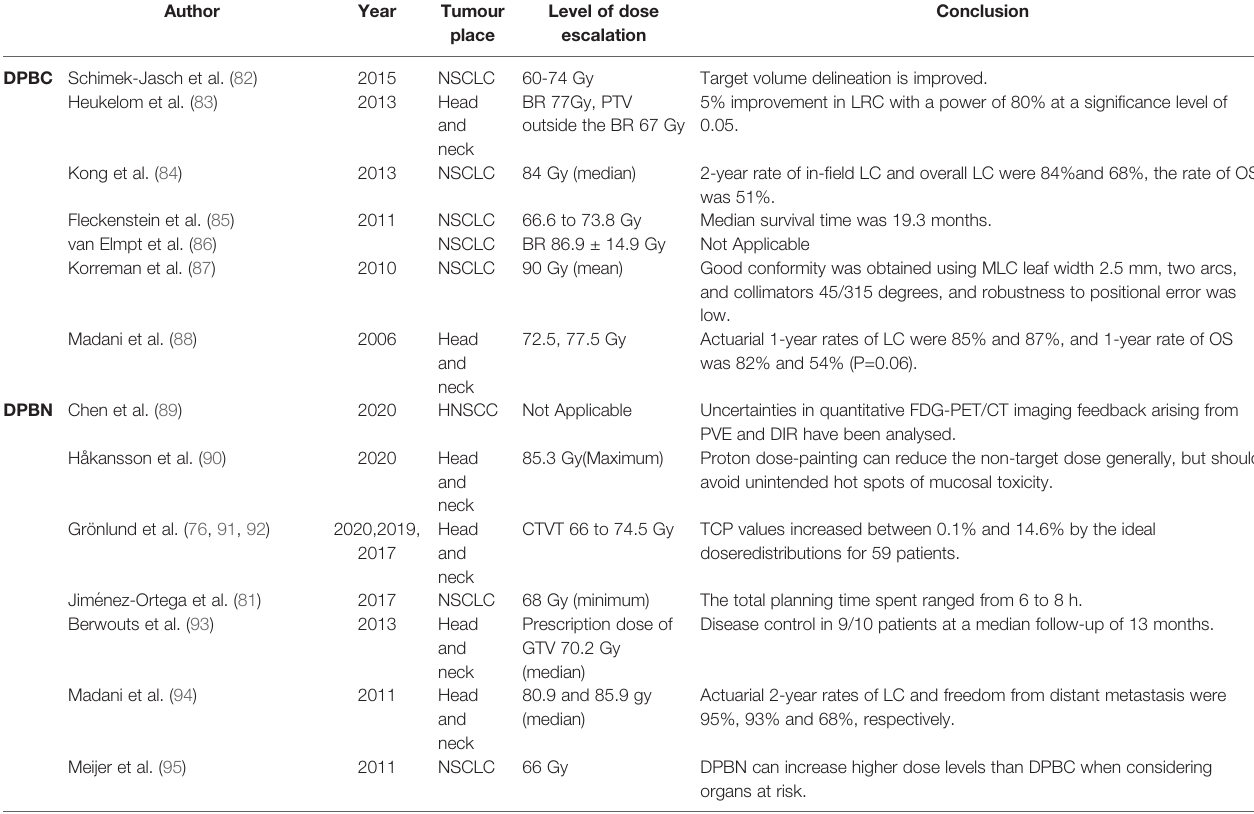
TABLE 2 | A review of the state-of-the-art DPBC and DPBN